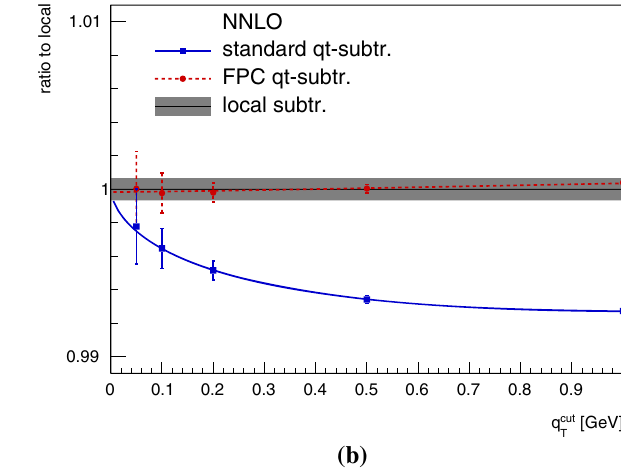
out FPC (red circled points) at various values of q cut subtraction method (black line). Error bars indicate the statisticaluncer- tainties from Monte Carlo numerical integration